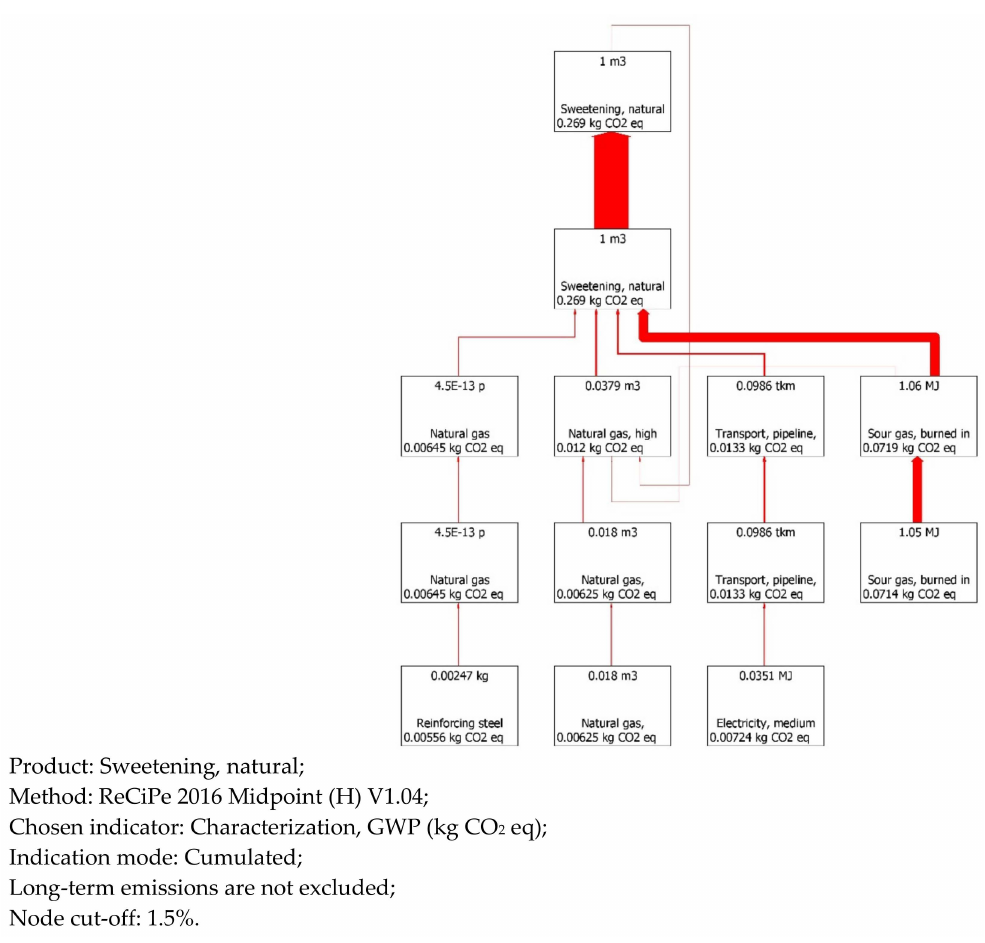
Figure A2. Structural data inventory flows used in the Ecoinvent database in for the GWP in (kg CO 2